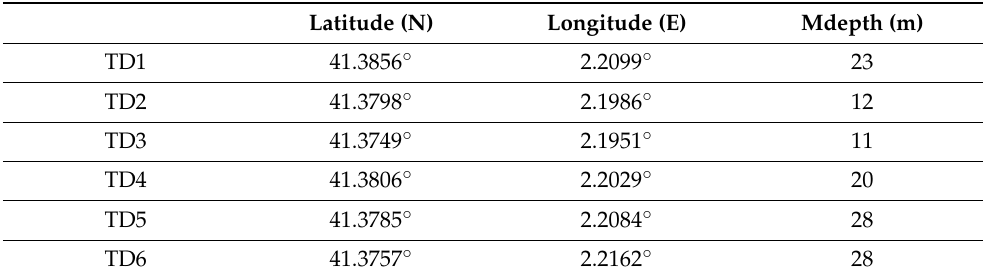
Table 3. Position of the six measurement stations, showing the maximum depth (Mdepth) reached by the TD profiler. The bottom depth in stations TD5 and TD6 is about 30 and 40 m, respectively.